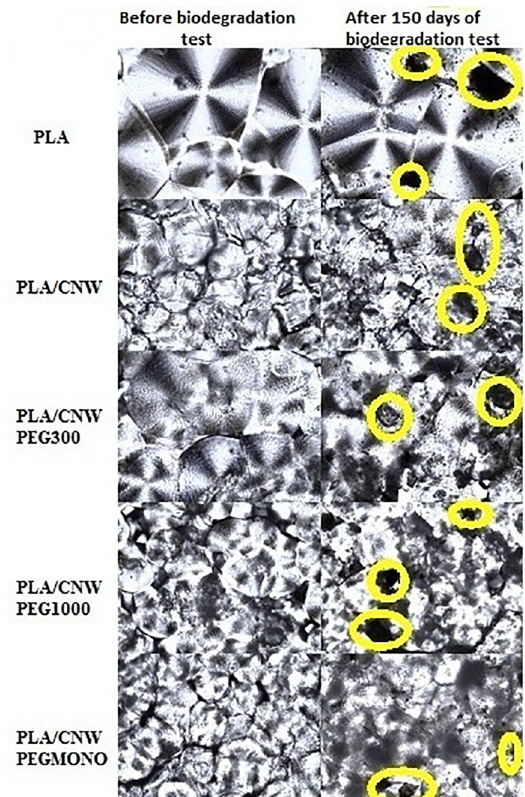
Figure 3. Optical micrographs of these films before and after 150 days of soil biodegradation.